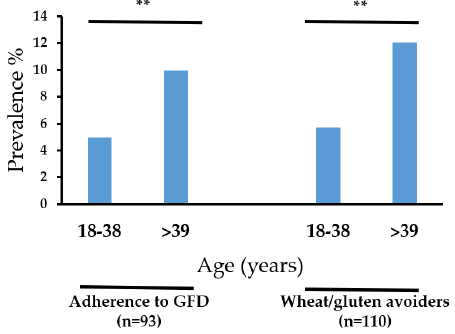
Figure 1. Characteristics of individuals following a GFD. Acronyms used: SR-PD: Self-Reported Physician-Diagnosed; SR: Self Reported; GFD: Gluten-free Diet; SR-NCGS: Self-Reported Non-Celiac Gluten Sensitivity; Non-SR-GS: Non Self-Reported Gluten Sensitivity.